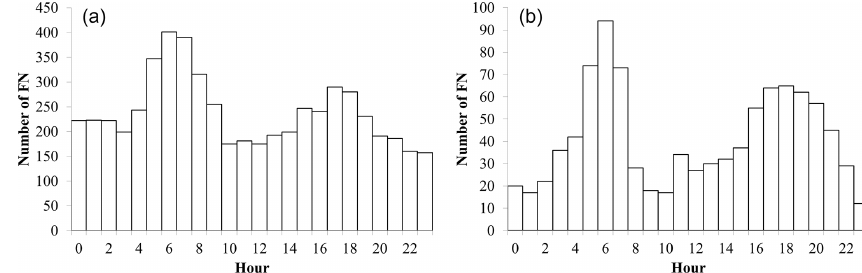
Figure 14. Hourly distribution of FN. (a) For the period 2020–2021. (b) For July and August 2020 and